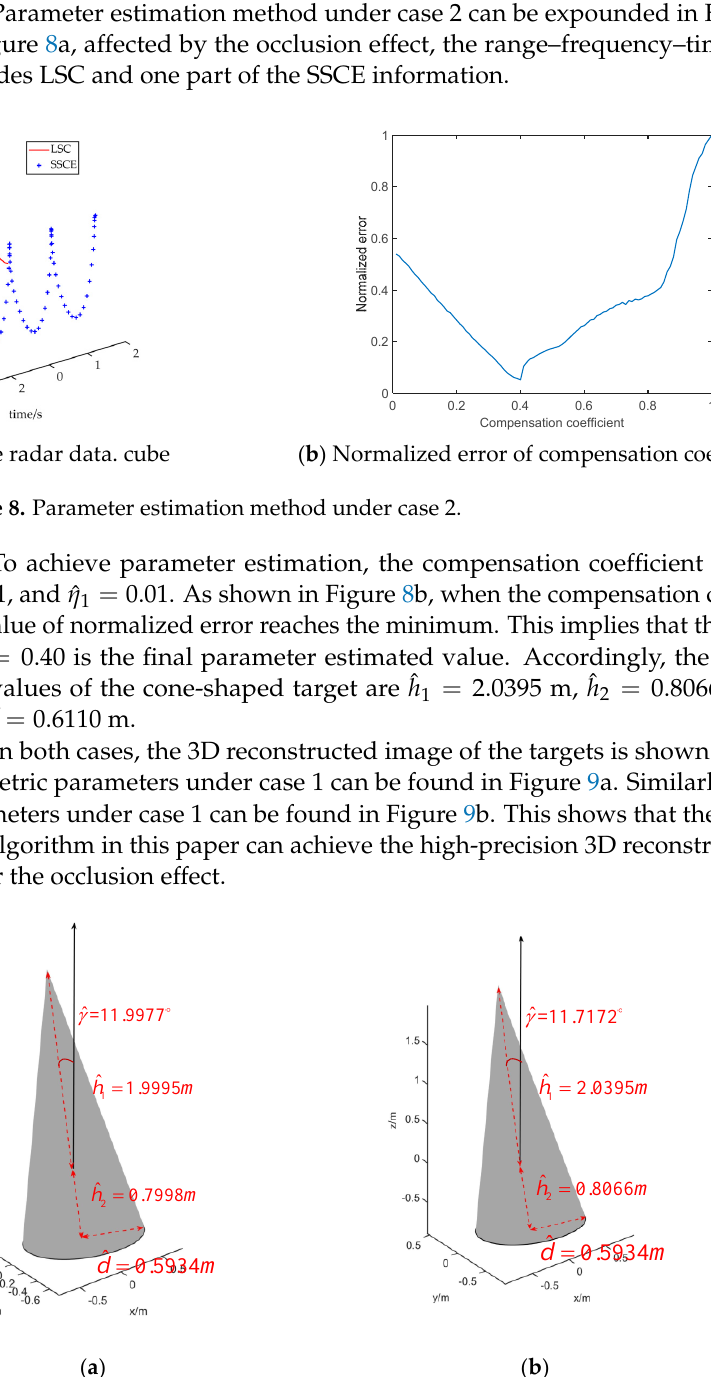
Figure 9. Three-dimensional reconstructed image.